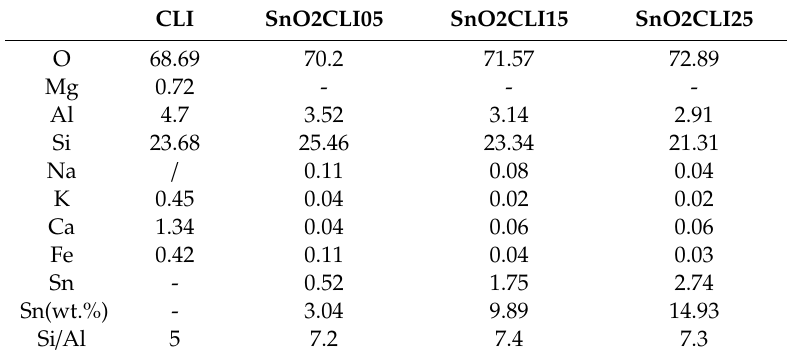
Table 1. Average elemental composition (at.%) of clinoptilolite (CLI) and SnO 2 -containing clinoptilolite obtained by the energy-dispersive X-ray (EDX) analysis. For clarity, Sn contents are shown also as wt.%. CLI SnO2CLI05 O 68.69